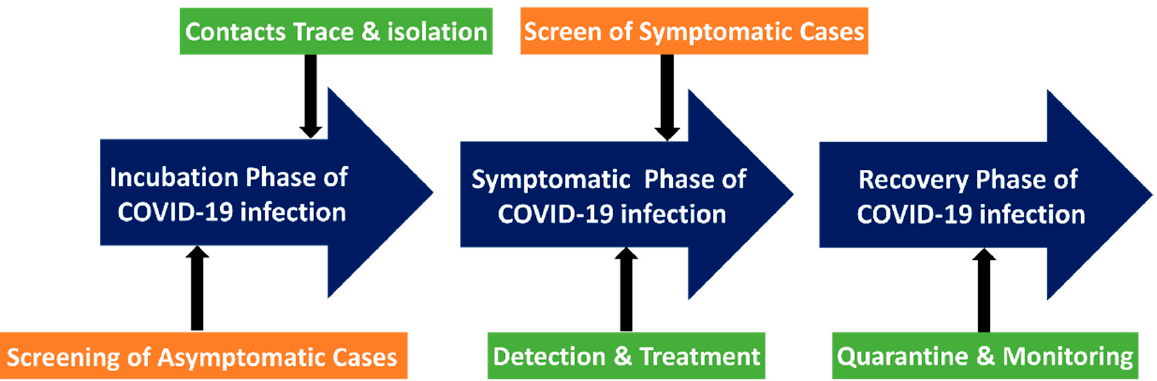
Figure 8. In order to screen the COVID-19 patients, diagnostic testing at point of care could be employed. The screening could happen at any time, from the incubation stage to the symptomatic stage. At various stages, various measures were implemented .